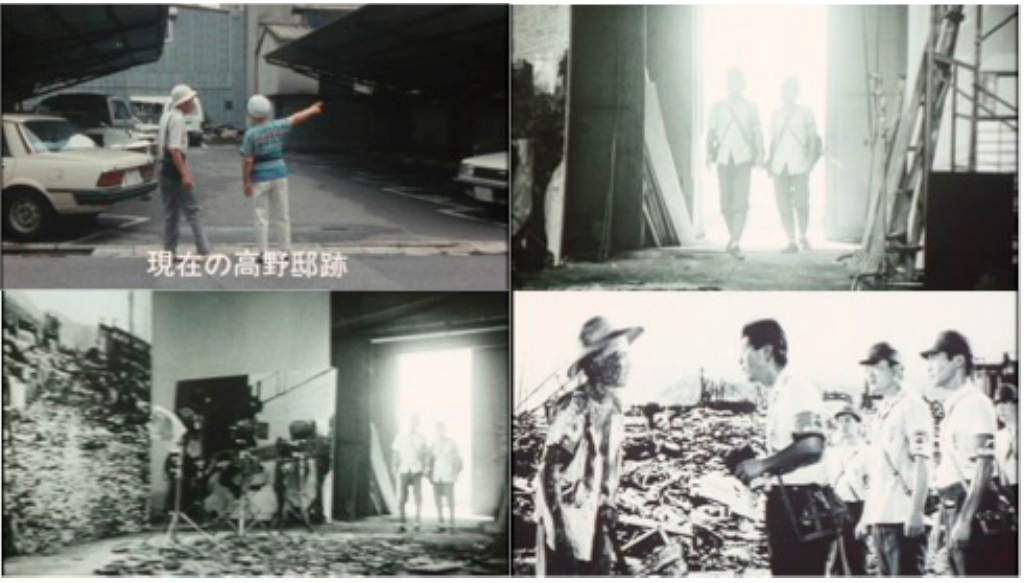
Figure 7. Sakuratai 8.6 (Shind ō Kaneto, 1988).